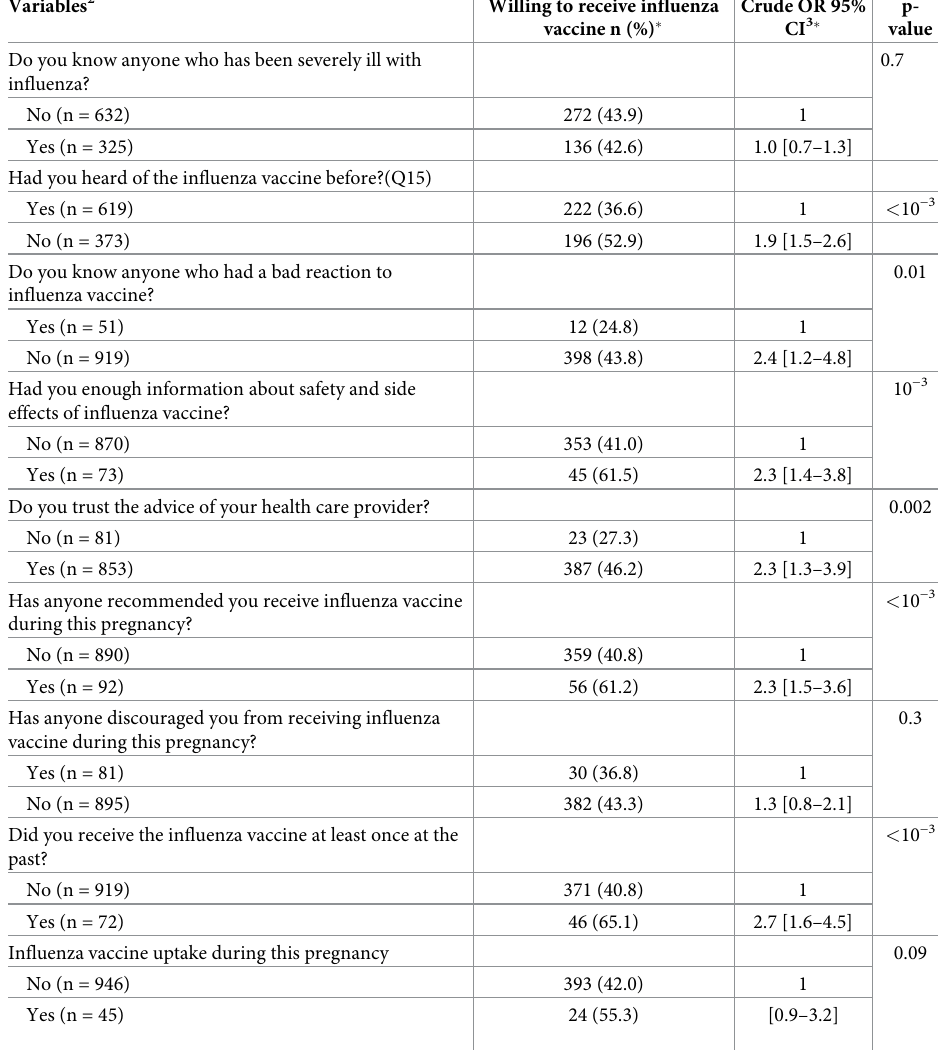
Table 2. Knowledge and attitudes towards influenza and influenza vaccination and their association with willing- ness to receive influenza vaccine during pregnancy 1 . Variables 2 Willing to receive influenza